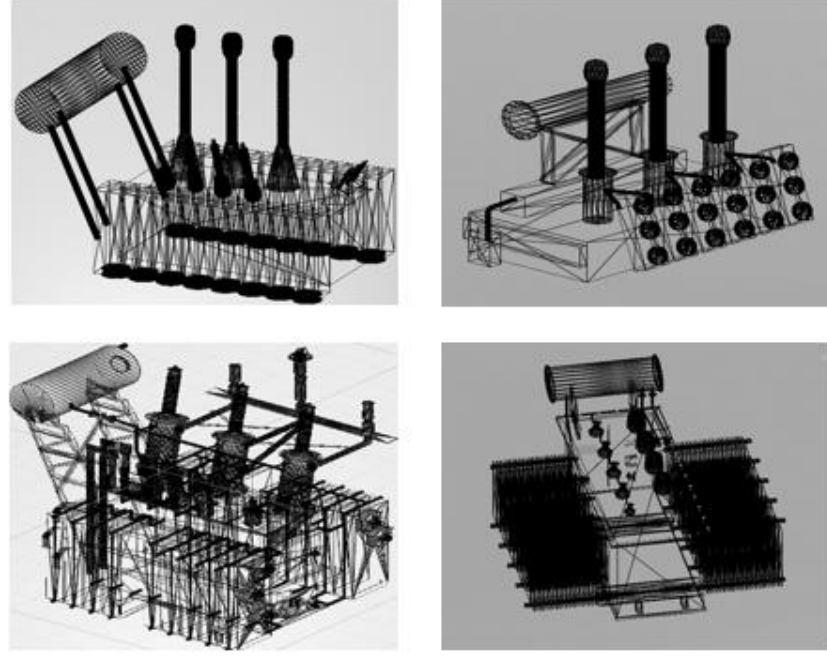
Figure 10. Four power transformers constructed in this research.